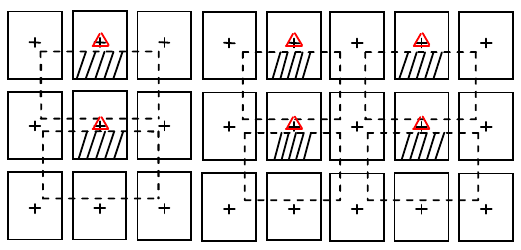
Figure 7. control images (the red triangle)